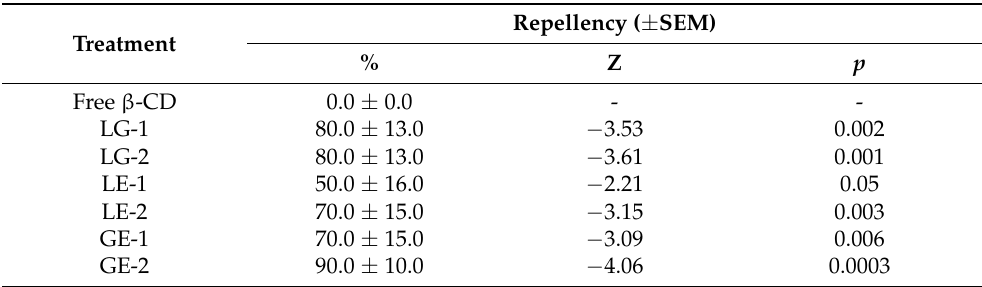
Table 5. Mean percentage of repelled ( ± SEM) ticks exposed to different treatments in vertical bioassays (N = 10).